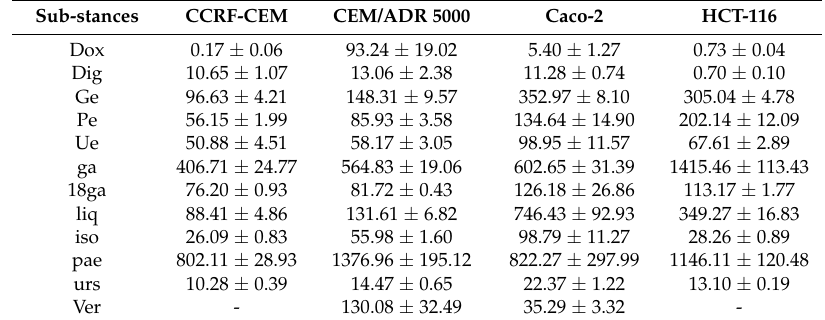
Table 2. Cytotoxicity (IC 50 values *) of individual extracts or secondary metabolites in four kinds of cancer